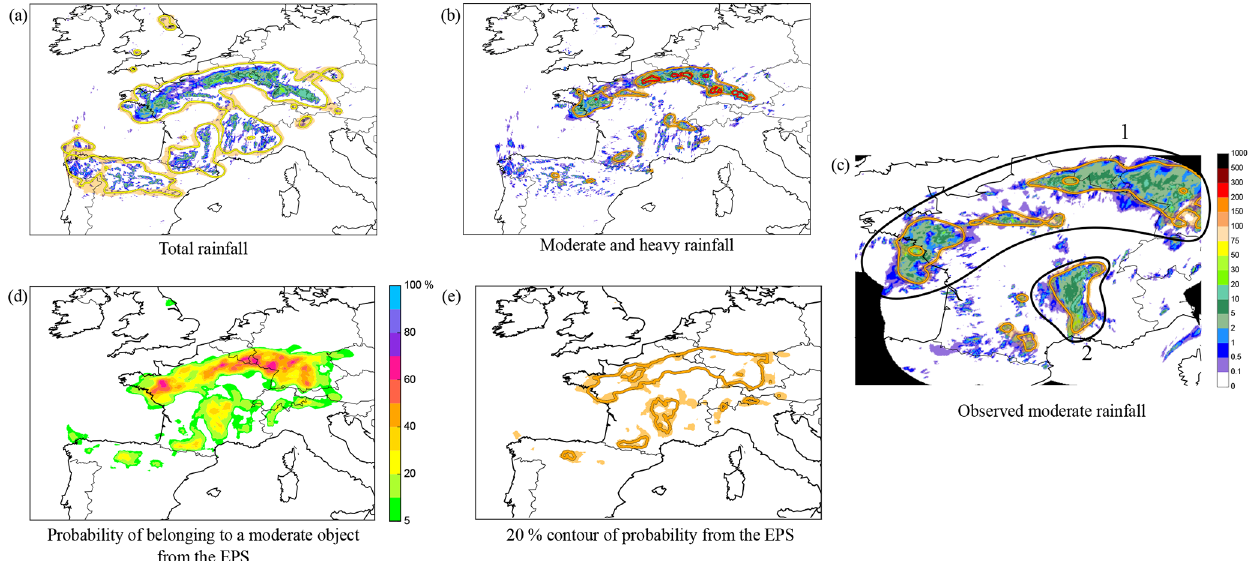
Figure 2. (a) Total rainfall objects detected from hourly accumulated precipitation in the deterministic forecast by the AROME model for the 11 June 2018 at 16:00UTC (the simulation started the 11 June 2018 at 00:00UTC). (b) Same as (a) for moderate and heavy rainfalls, respectively in orange, and red. (c) Moderate rainfall objects detected from hourly accumulated precipitation from radar observations valid 11 June 2018 at 16:00UTC. Two main areas of precipitation are identified. (d) Probability of belonging to a moderate object according to the 12 members of AROME EPS for the the 11 June 2018 at 16:00UTC (the simulation started the 10 June 2018 at 21:00UTC). (c) The 20% contour of the probability